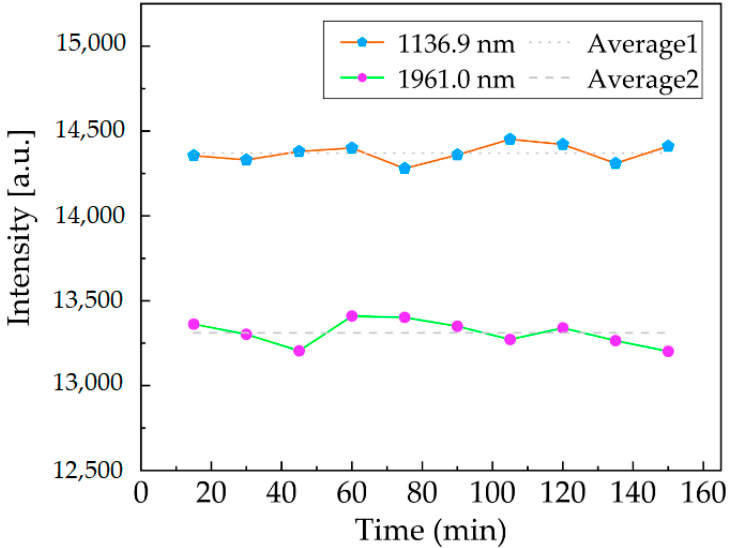
Figure 7. Ten measurements of spectral peak fluctuation at 1136.9 nm and 1961.0 nm.